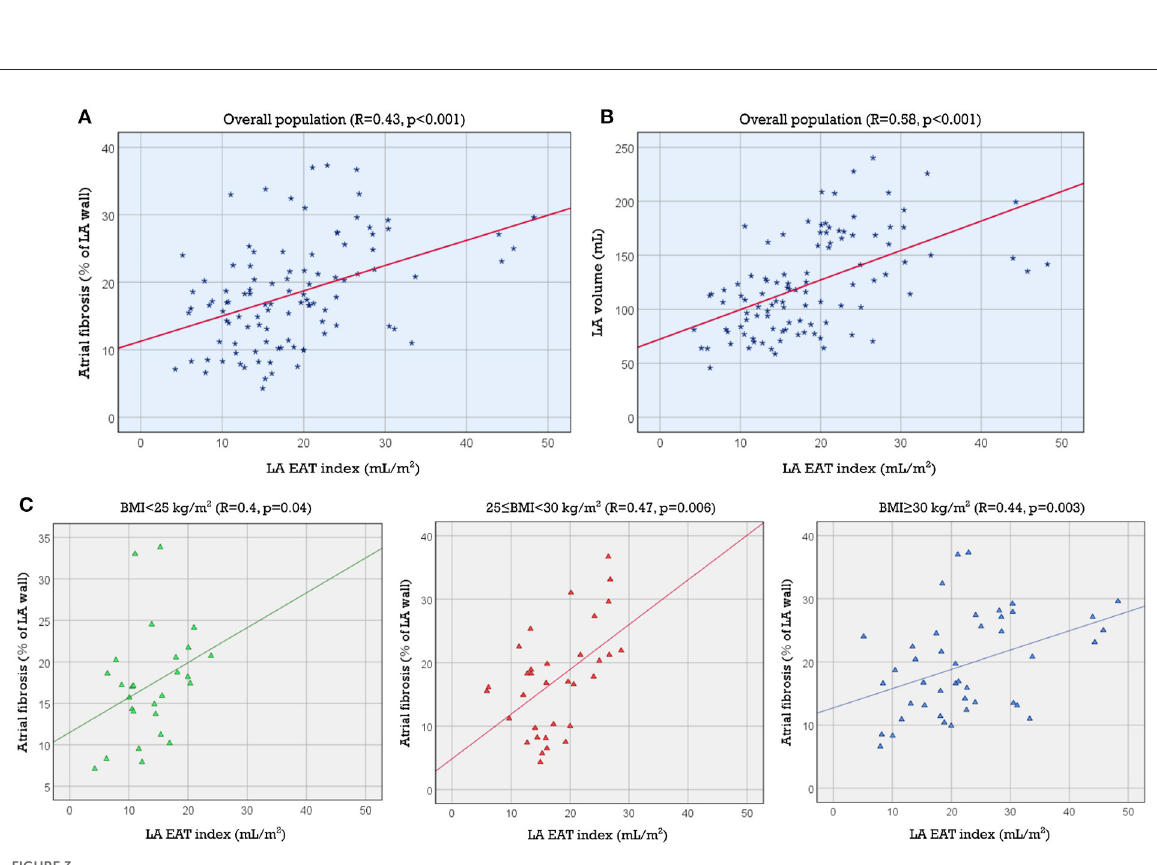
FIGURE3 Association of LA EAT index with LA volume and fibrosis. Scatter plots showing the association between LA EAT index and LA volume in the study population (A) and the association between LA EAT index and LA fibrosis (B) in the study population and (C) in each of the 3 BMI categories (normal, overweight and obese). BMI, body mass index; EAT, epicardial adipose tissue; LA, left